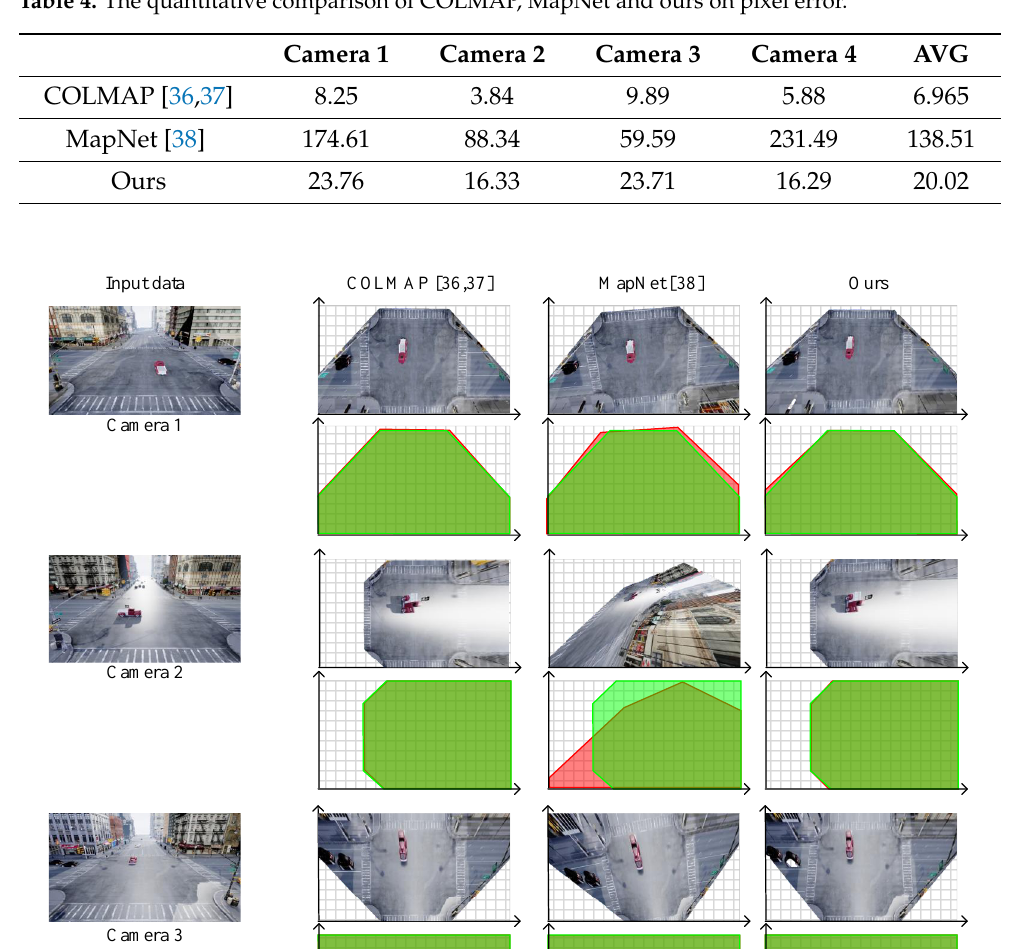
Table 4. The quantitative comparison of COLMAP, MapNet and ours on pixel error.